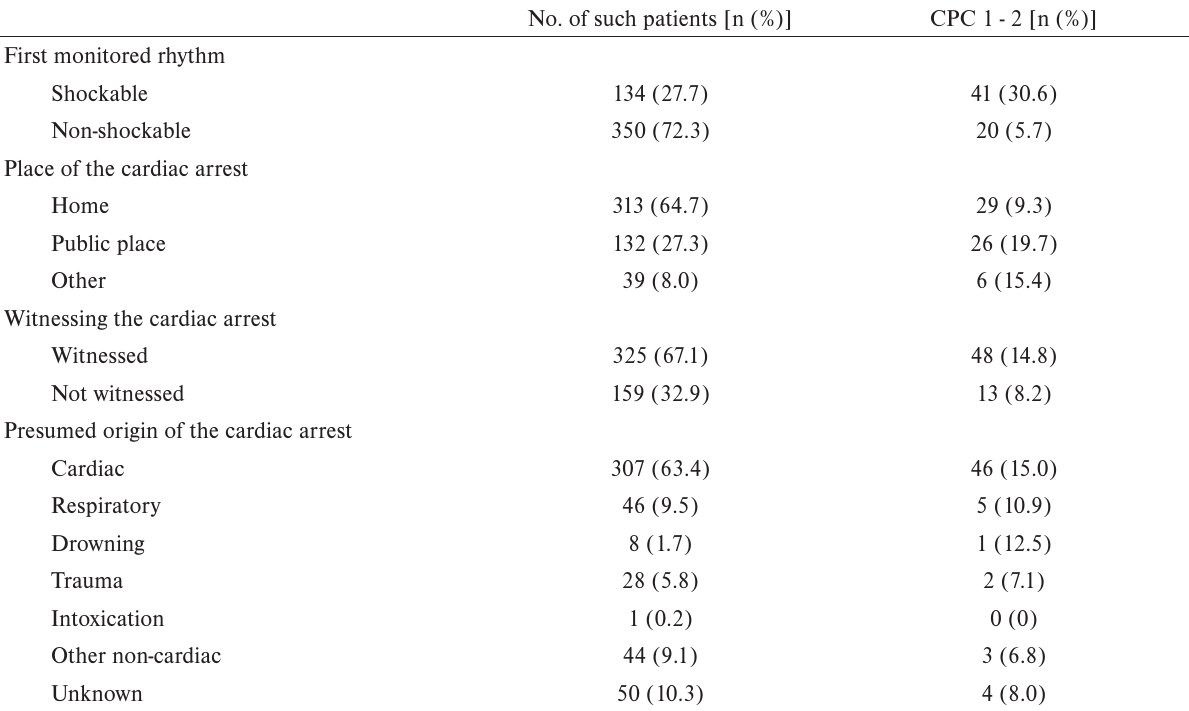
Table 3. Comparison of survival rates in first rhythm/place of arrest/witnessing the cardiac arrest/presumed origin subgroups. No. of such patients [n (%)]